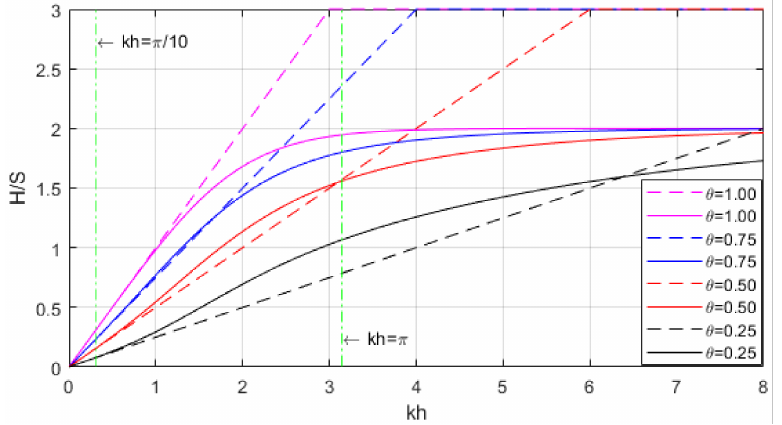
Figure 2. Wave height to wavemaker stroke relationship ( H / S ) in the function of kh . Comparison of Solutions (16) and (37) for different values of θ